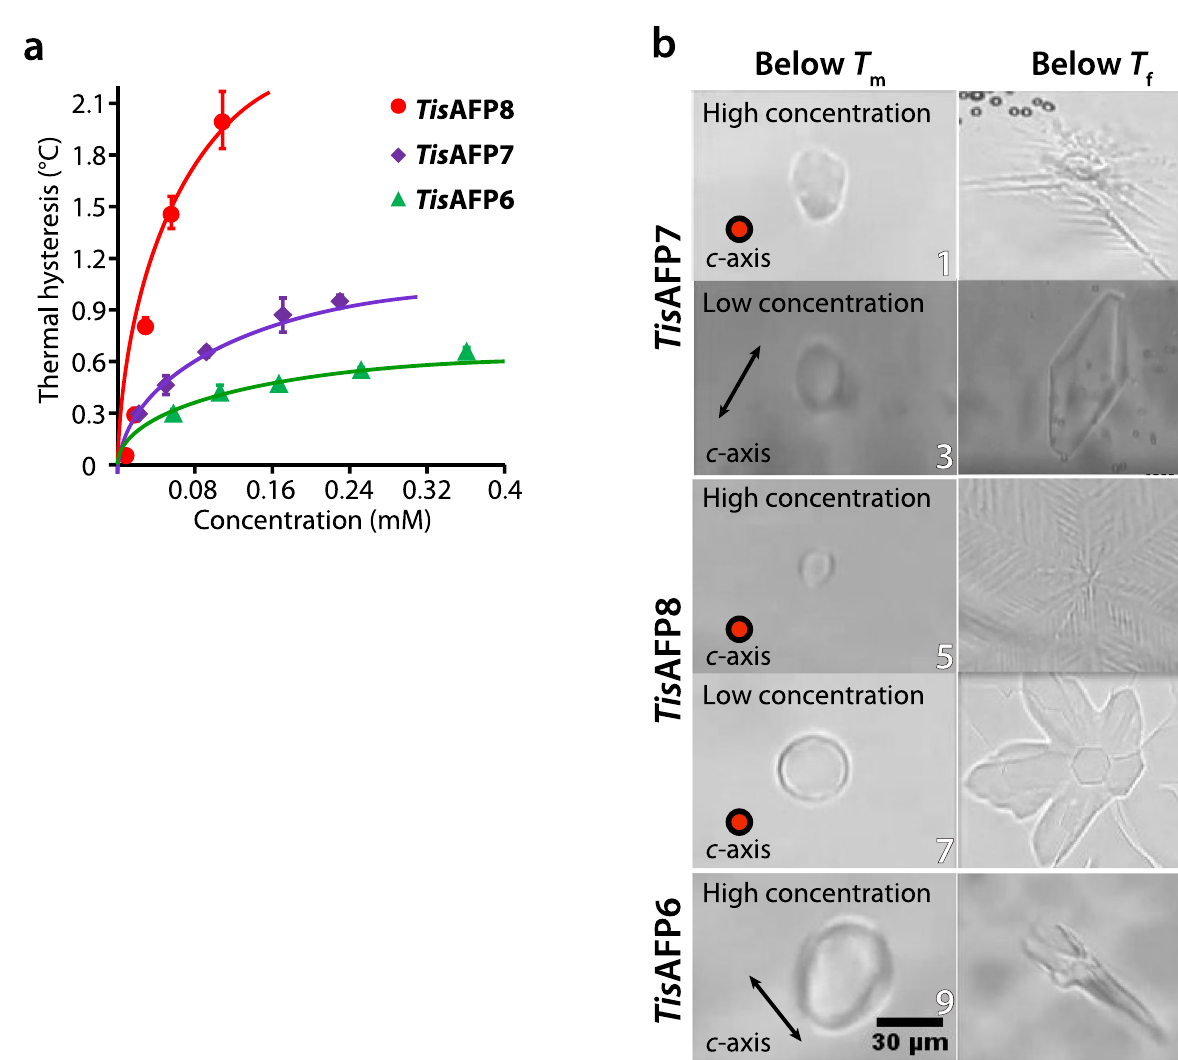
growth along the c -axis could be ascribed to AFP binding to the basal plane of ice crystal, as proposed by Scotter et al. 10 , a hallmark of hyperactive AFP. We showed that Tis AFP7 bound to the basal plane at high concentra- tion (0.23 mM). At a relatively low concentration (0.01 mM), the seed ice crystal changed shape to a hexagonal bipyramid with truncated tips in the TH gap, and then grew rapidly, maintaining the bipyramidal shape (Fig. 1b, panels 3 and 4). This indicated that Tis AFP7 affects the ice morphology and ice-bursting pattern in a concentra-